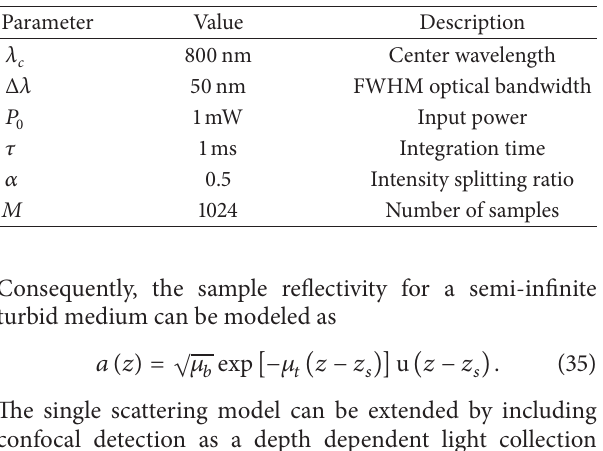
Table 1: Parameters used in the OCT